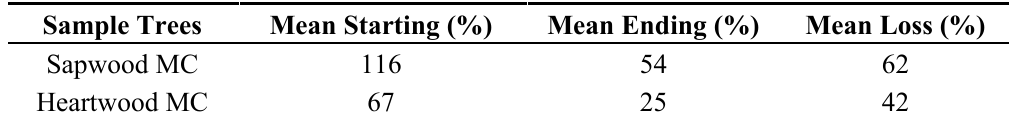
Table 4. The beginning and ending stem moisture contents of all sample stems regardless of size separated by heartwood and